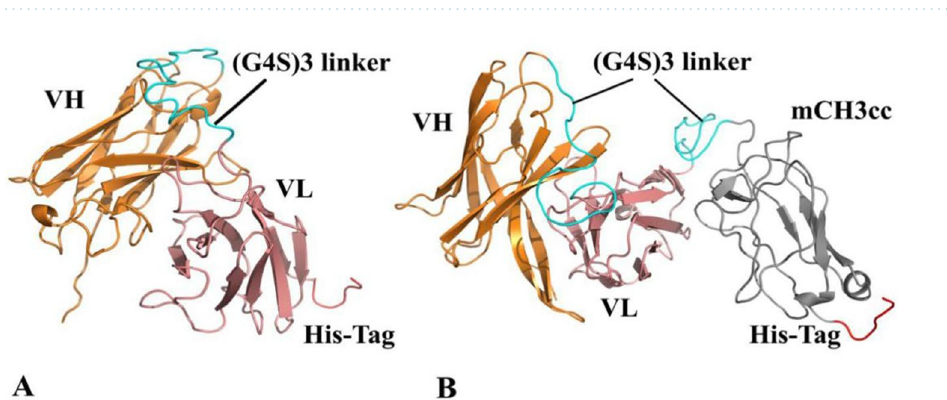
Figure 2. Cartoon representation of predicted 3D structures: (A) YFL002; ( B) YFL001. VH, VL, linker, mCH3cc and His tag are shown in orange, pink, cyan, gray and red,